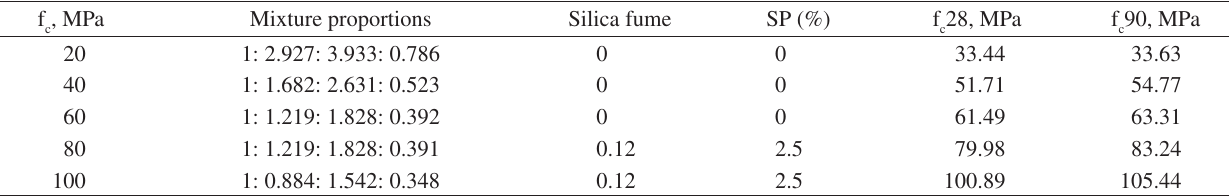
Table 2. Concrete mixture proportions and the strength of concrete. f , MPa Mixture proportions c